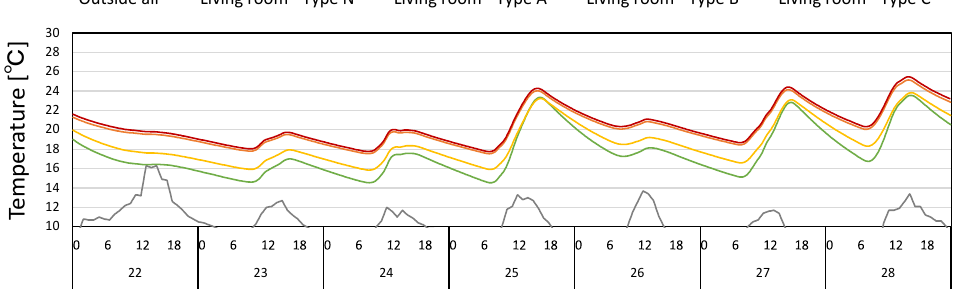
Figure 9. Comparison of living-room temperature by each type (February).